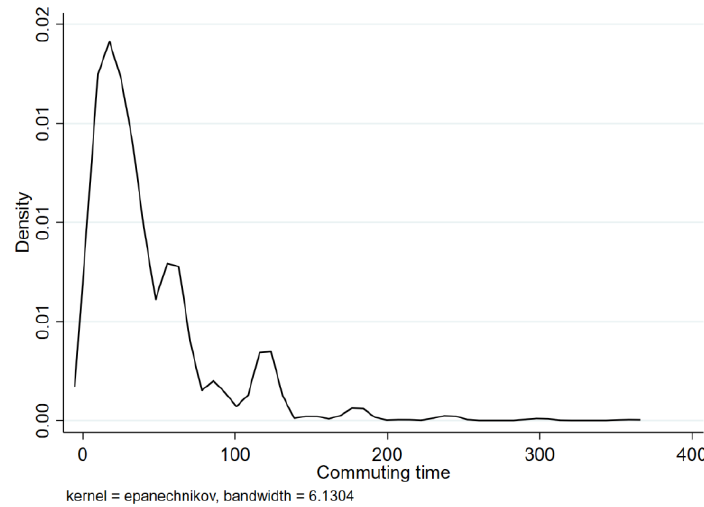
Figure 1. Distribution of commuting time.